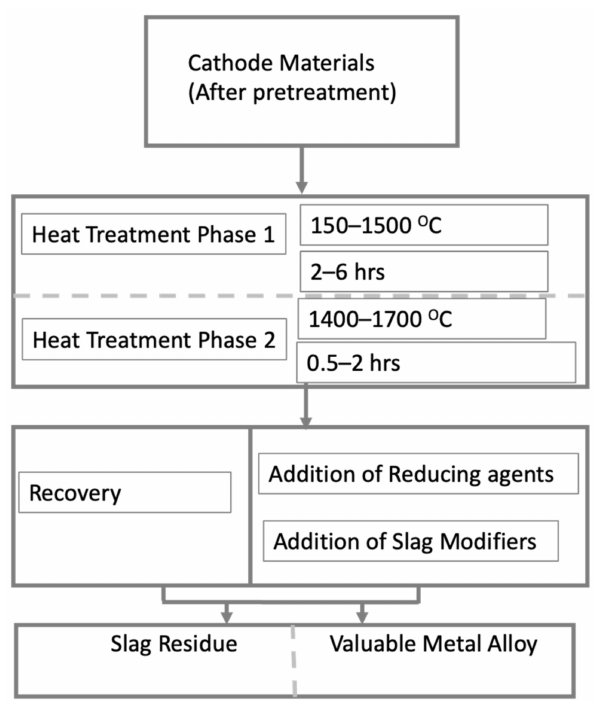
Figure 9. Conventional pyrometallurgical processes for spent Li-ion batteries (Data gathered from refs.